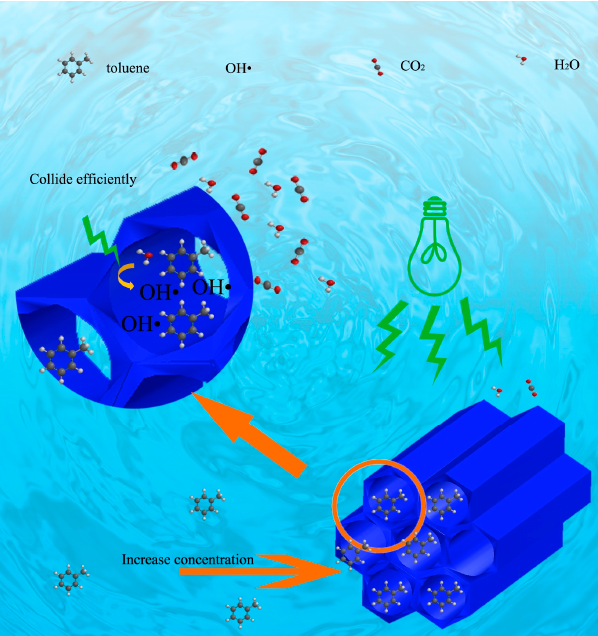
Figure 9. ( a ) The photocatalytic performance curve of 20%-TiO 2 -SBA-15 samples before and after hydrothermal treatment, ( b ) The photocatalytic performance of 20%-TiO 2 -SBA-15 and 20%-P25-SBA-15.